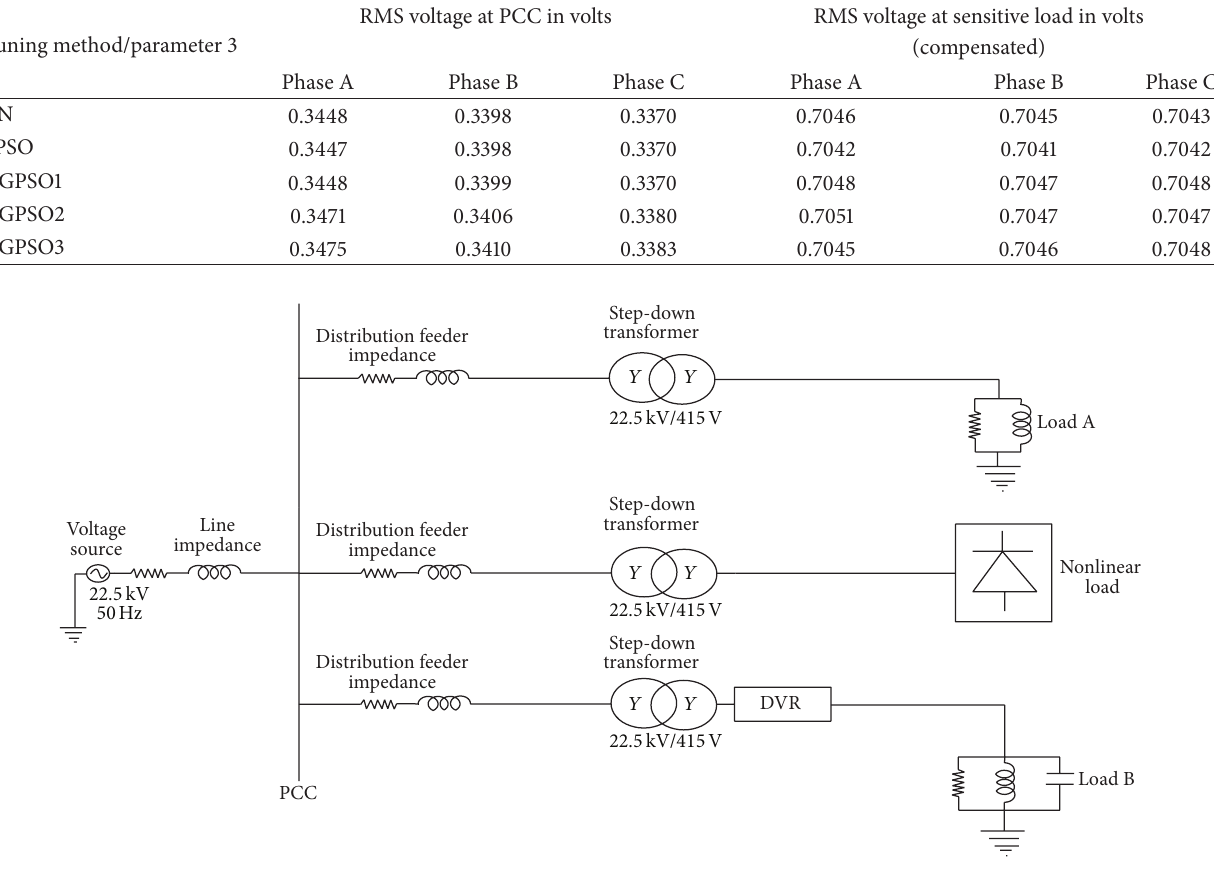
Figure 4: Test system with nonlinear load.